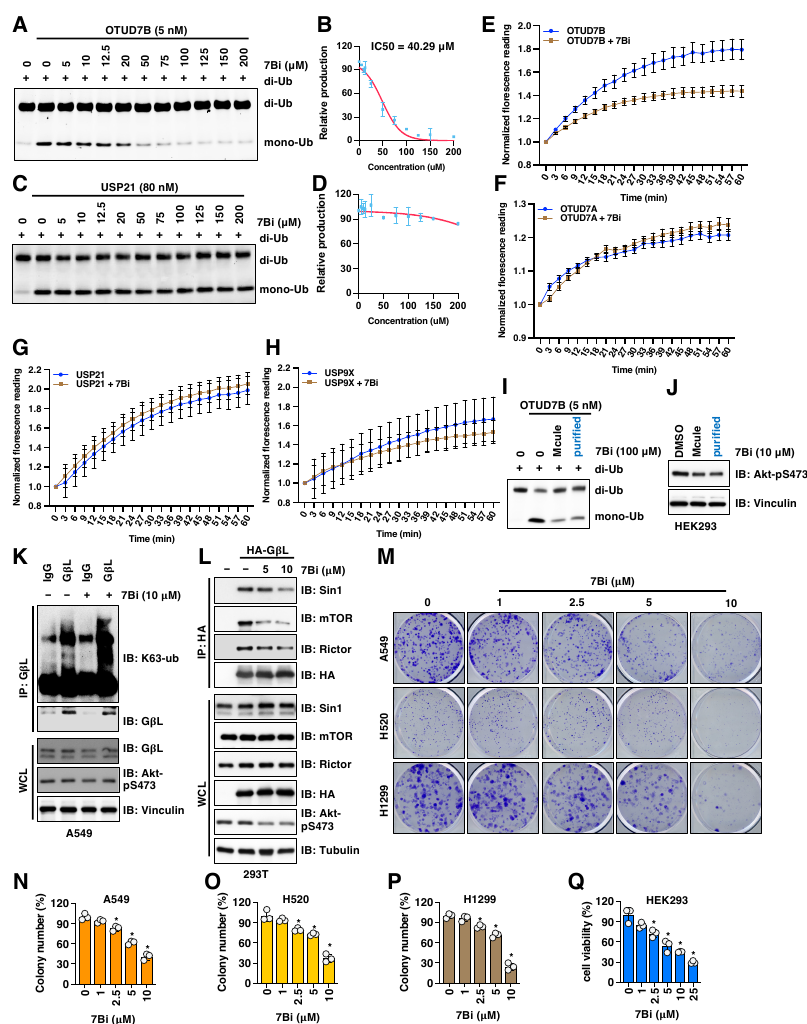
Figure 3. 7Bi inhibits OTUD7B activity in vitro and suppress cell growth in NSCLC cells. ( A , B ) A representative gel image ( A ) for the in vitro OTUD7B deubiquitination assay incubating 5 nM of recombinant OTUD7B with 0.5 µ M of K11-linked di-ub for 10 min in the presence of indicated doses of 7Bi. Mono-ub was quantified for IC50 value determination ( B ). ( C , D ) A representative gel image ( C ) for the in vitro USP21 deubiquitination assays incubating 80 nM of recombinant active USP21 proteins with 0.5 µ M of K11-linked di-ub for 10 min in the presence of indicated doses of 7Bi. Mono-ub was quantified for IC50 value determination ( D ). ( E – H ) In vitro deubiquitination assays using ubiquitin-AMC as a substrate and indicated deubiquitinases. Normalized reading vs. reaction time periods was plotted. ( I ) A representative gel image for the in vitro OTUD7B deubiquitination assay incubating 5 nM of recombinant active OTUD7B proteins with 0.5 µ M of K11-linked di-ub for 10 min in the presence of 100 µ M of 7Bi (from either Mcule (90% purity) or recrystallized (99% purity)). ( J ) IB analysis of WCL derived from HEK293 cells treated with 10 µ M of 7Bi (from either Mcule (90% purity) or recrystallization-purified (99% purity)). ( K ) IB analyses of G β L-IP and WCL from A549 cells treated with control or 10 µ M 7Bi for 16 h. ( L ) IB analyses of HA-IP and WCL from HEK293 cells transfected with indicated DNA constructs. Where indicated, indicated doses of 7Bi were used to treat cells for 16 h before cell collection. ( M ) Representative colony formation images from indicated NSCLC cells treated with indicated doses of 7Bi once for 10 days and quantified in ( N – P ). Error bars were calculated as mean ± SD, n = 3. * p < 0.05 (one-way ANOVA test). ( Q ) Quantifications of cell viability by MTT assays in HEK293 cells treated with indicated doses of indicated compounds for 72 h. Error bars were calculated as mean ± SD, n = 3. * p < 0.05 (one-way ANOVA